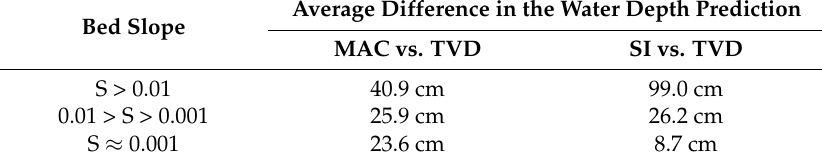
Table 4. Average difference in water depth predictions between the MAC and TVD, and SI and TVD model configurations at the selected monitoring points in the Borth study